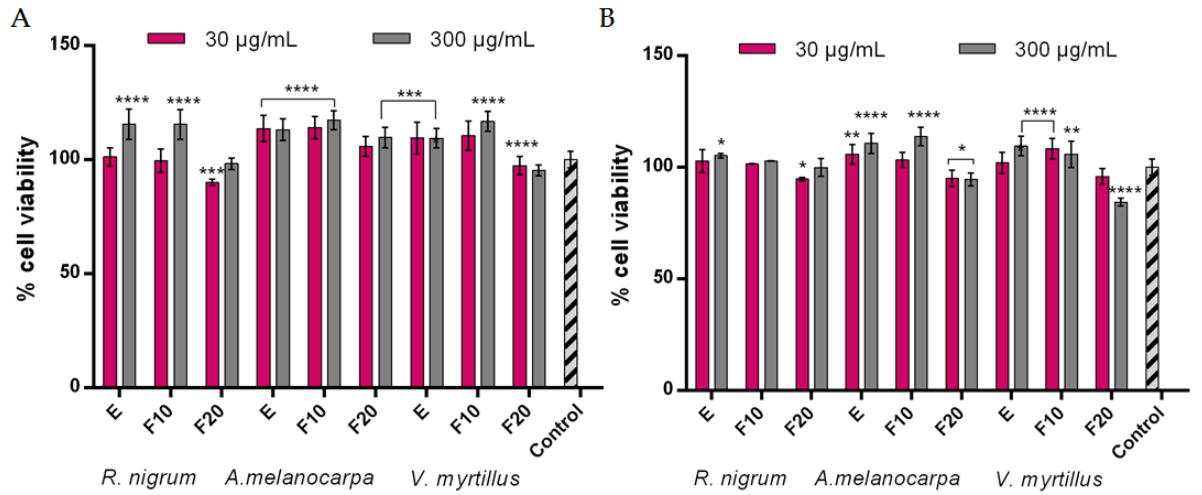
Figure 5. Effect of R. nigrum, A. melanocarpa , and V. myrtillus extracts and ferments (at the concen- tration of 30 and 300 µg/mL) on Alamar Blue assay ( A ) and neutral red dye uptake ( B ) in cultured fibroblasts (BJ) after 24 h of exposure. Data are the mean ± SD of three independent experiments, each consisting of three replicates per test group; **** p < 0.0001, *** p < 0.001, ** p < 0.01, and * p < 0.05 compared to the control.